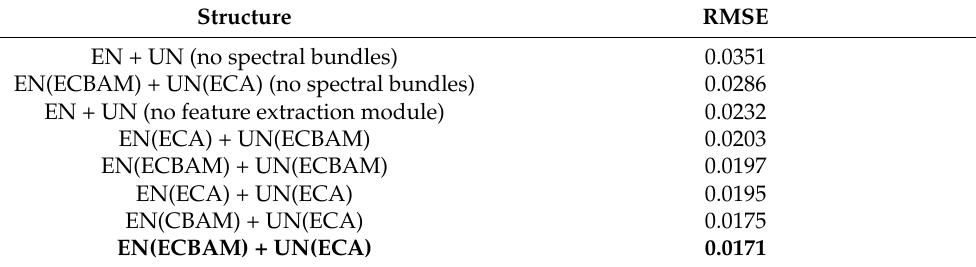
Table 6. Analysis of the ablation experiment for the Samson